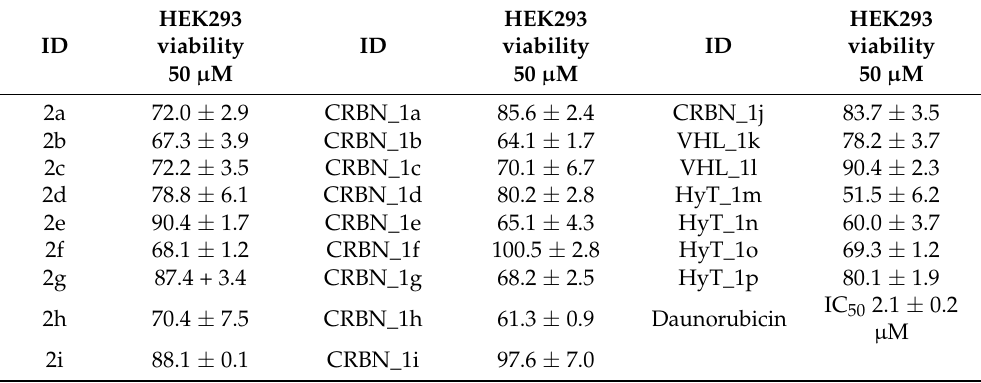
Table 3. Cytotoxicity on HEK293 cells (cell viability at 50 µ M inhibitor treatment). Daunorubicin was used as positive